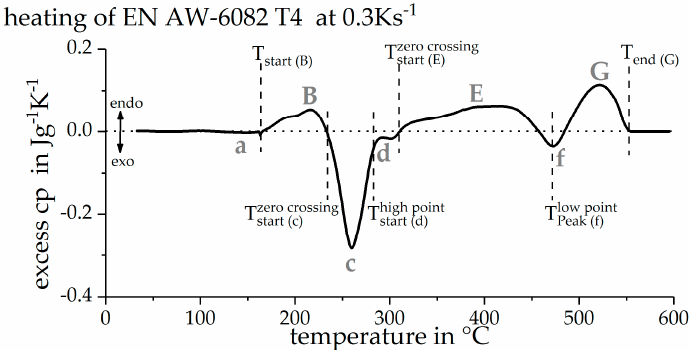
Figure 5. Separation and designation of the individual peaks using the example of a heating rate of 0.3 Ks − 1 .